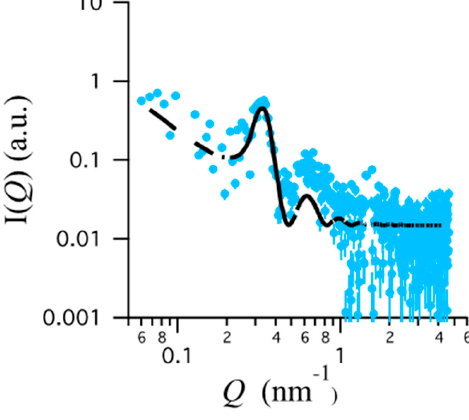
Figure 4. Data fitting for P-CA SAXS curve at 30 °C. Table 4. Fitting parameters of SAXS data of gels.